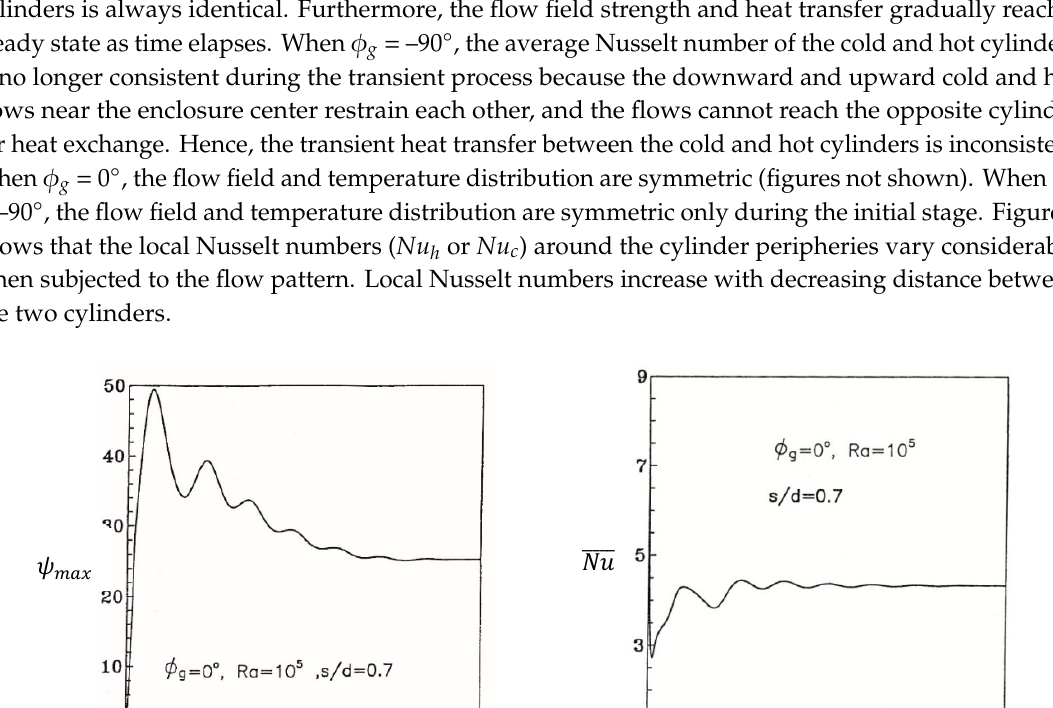
𝜓 (cid:3040)(cid:3028)(cid:3051)